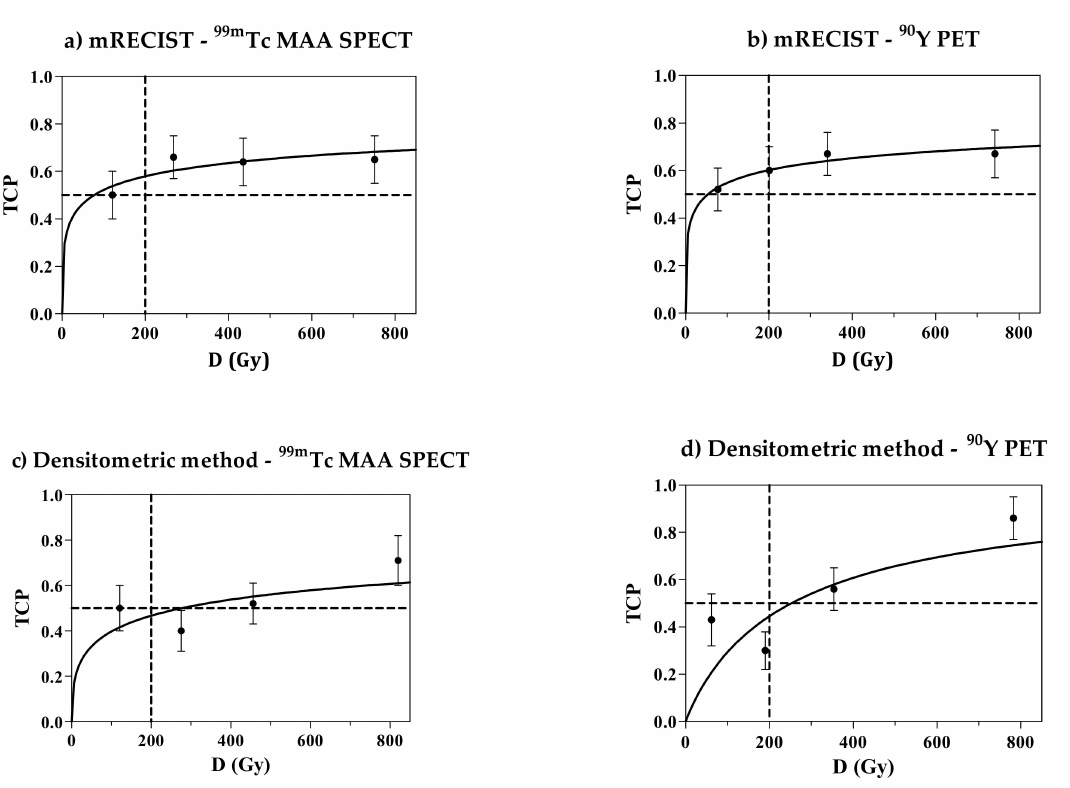
Figure 6. The 99m Tc-MAA SPECT ( a , c ) and 90 Y-PET ( b , d ) Tumour Control Probability (TCP) curves for the empirical log-logistic function fitting curves as function of the mean dose D (equation 6). The results of the mRECIST ( a , b ) and of the densitometric method ( c , d ) are presented. The dashed lines are a grid at 200 Gy and TCP = 50% to improve visual comparisons between different plots.